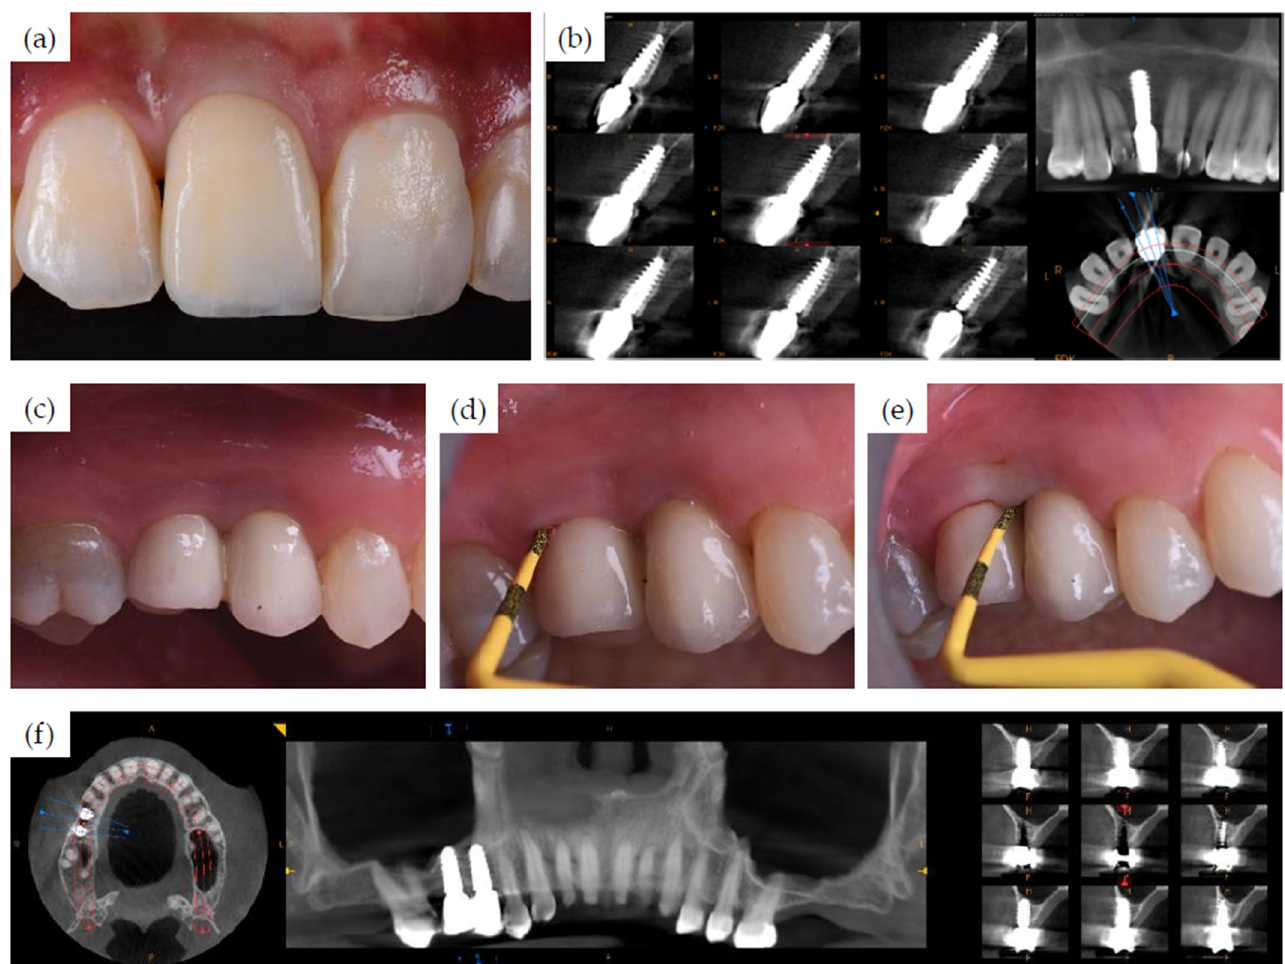
Figure 7. Clinical and radiographic follow-up. Clinical view ( a ) and CBCT ( b ) of the single implant- supported restoration of the missing maxillary central incisor at 32 months post implant